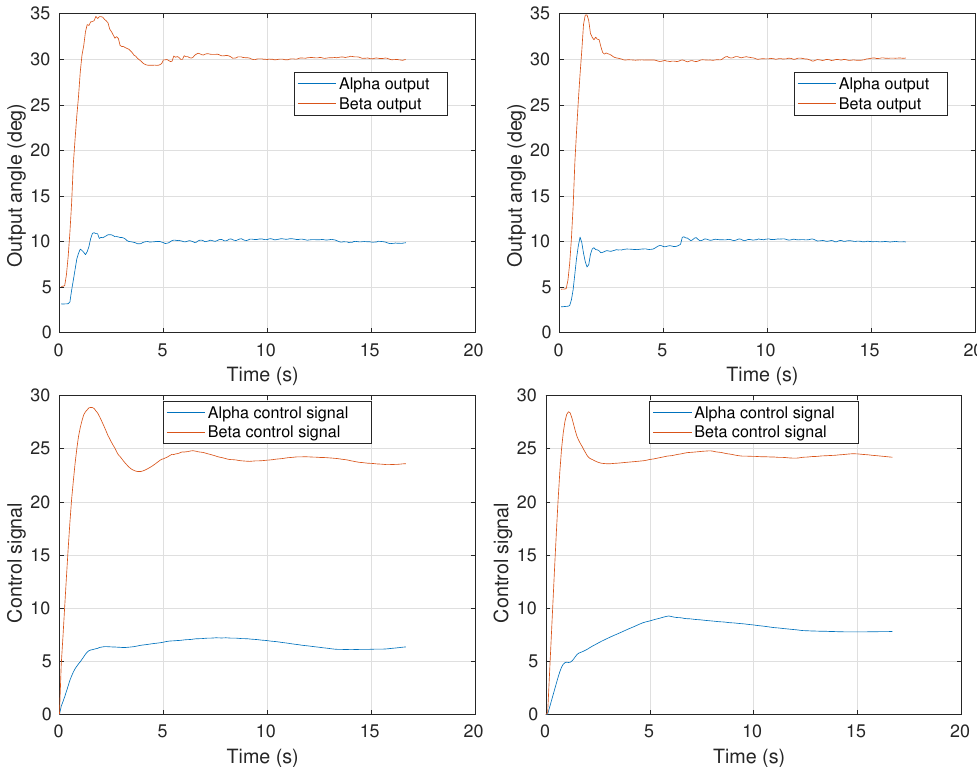
Figure 10. Experiment 1. Time response ( above ) and control signal ( below ) for the two controllers tested, fractional ( left ) and integer ( right ) orders.